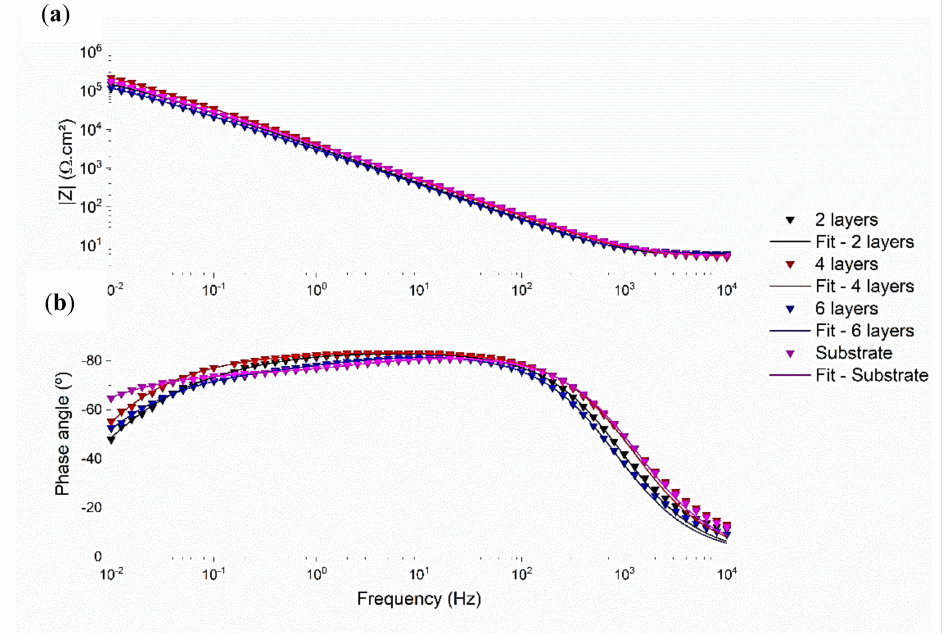
Figure 10. Bode diagrams: ( a ) impedance module vs. frequency; ( b ) phase angle vs.